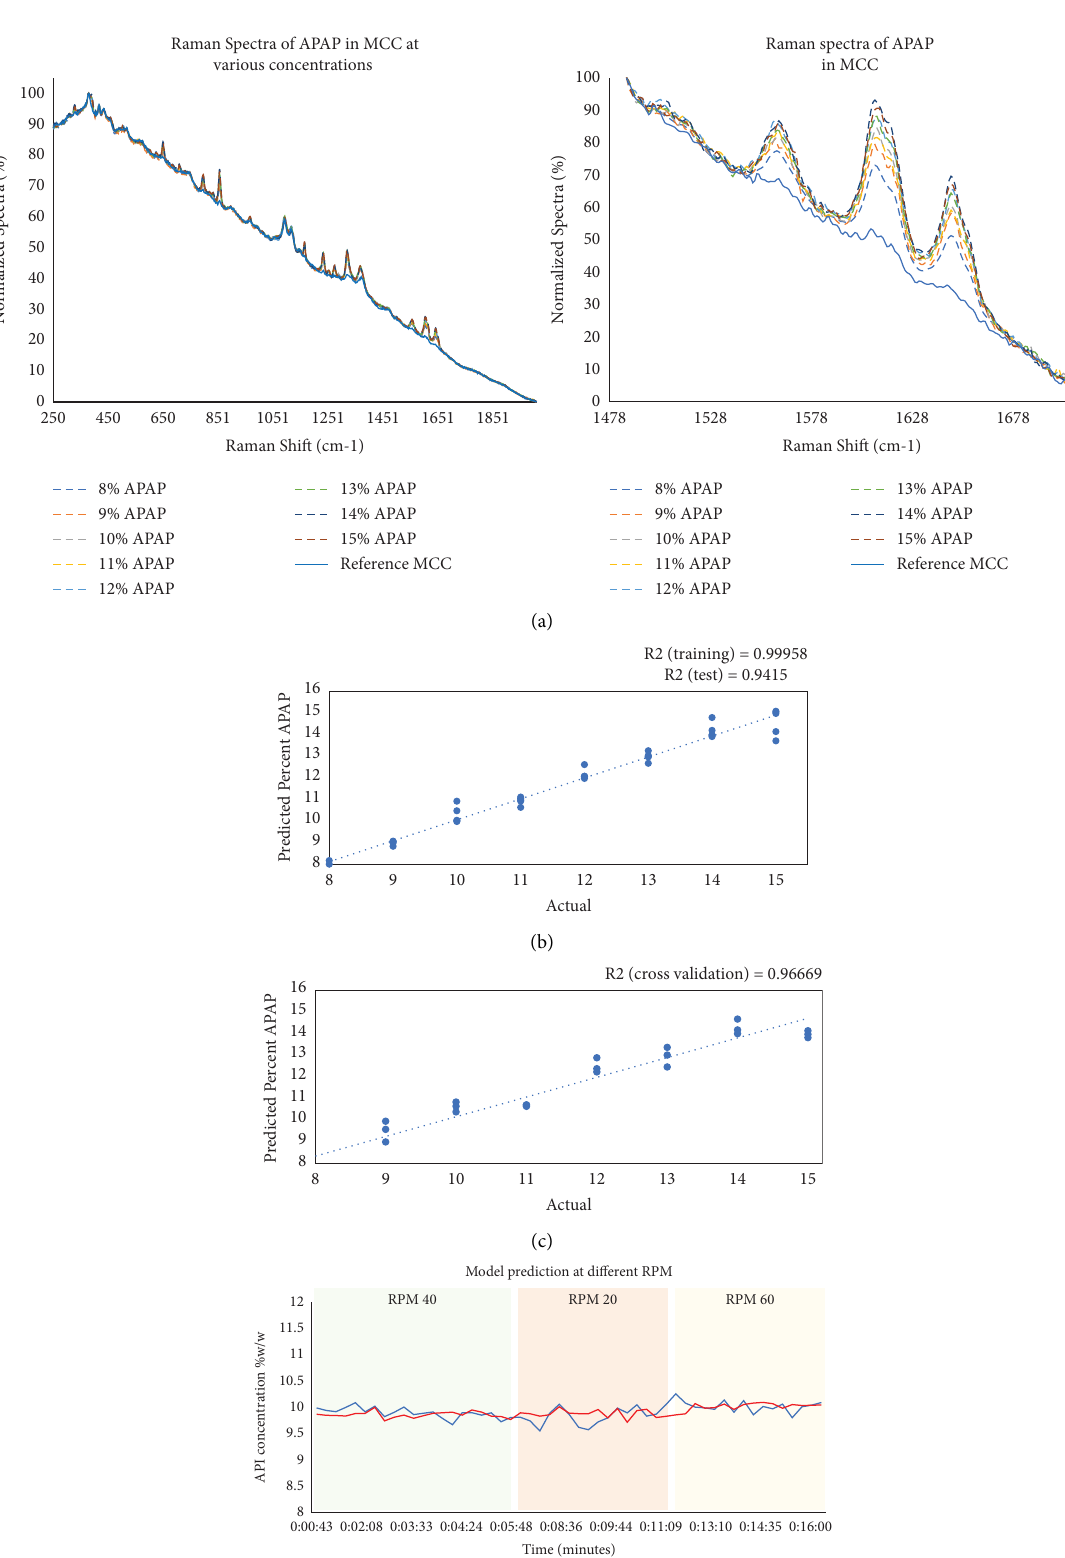
Figure 10: (a) Raman spectra of blends of API (8%, 9%, 10%, 11%, 12%, 13%, 14%, and 15%) in MCC, (b) predicted vs. actual training for APAP in MCC, (c) predicted vs. actual cross validation for APAP in MCC, and (d) predictions from PLS models at varying feeder RPM of feed